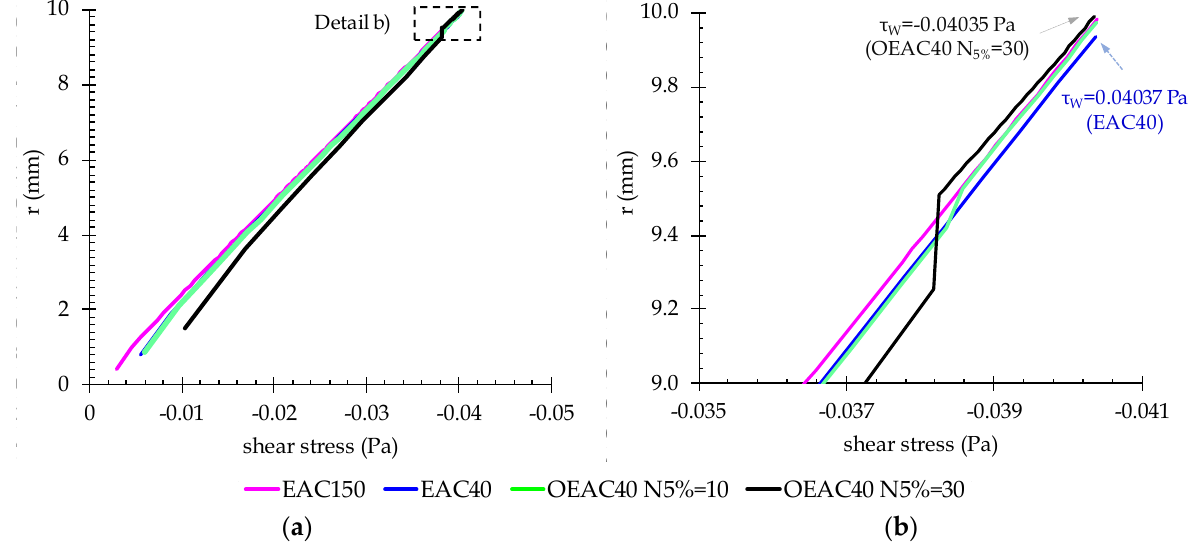
Figure 11. Shear stress profile for EAC40, EAC150, OEAC40 N5% = 10 and OEAC40 N5% = 30: ( a ) 0 ≤ r ≤ 10 mm; and ( b ) 9.0 ≤ r ≤ 10 mm.